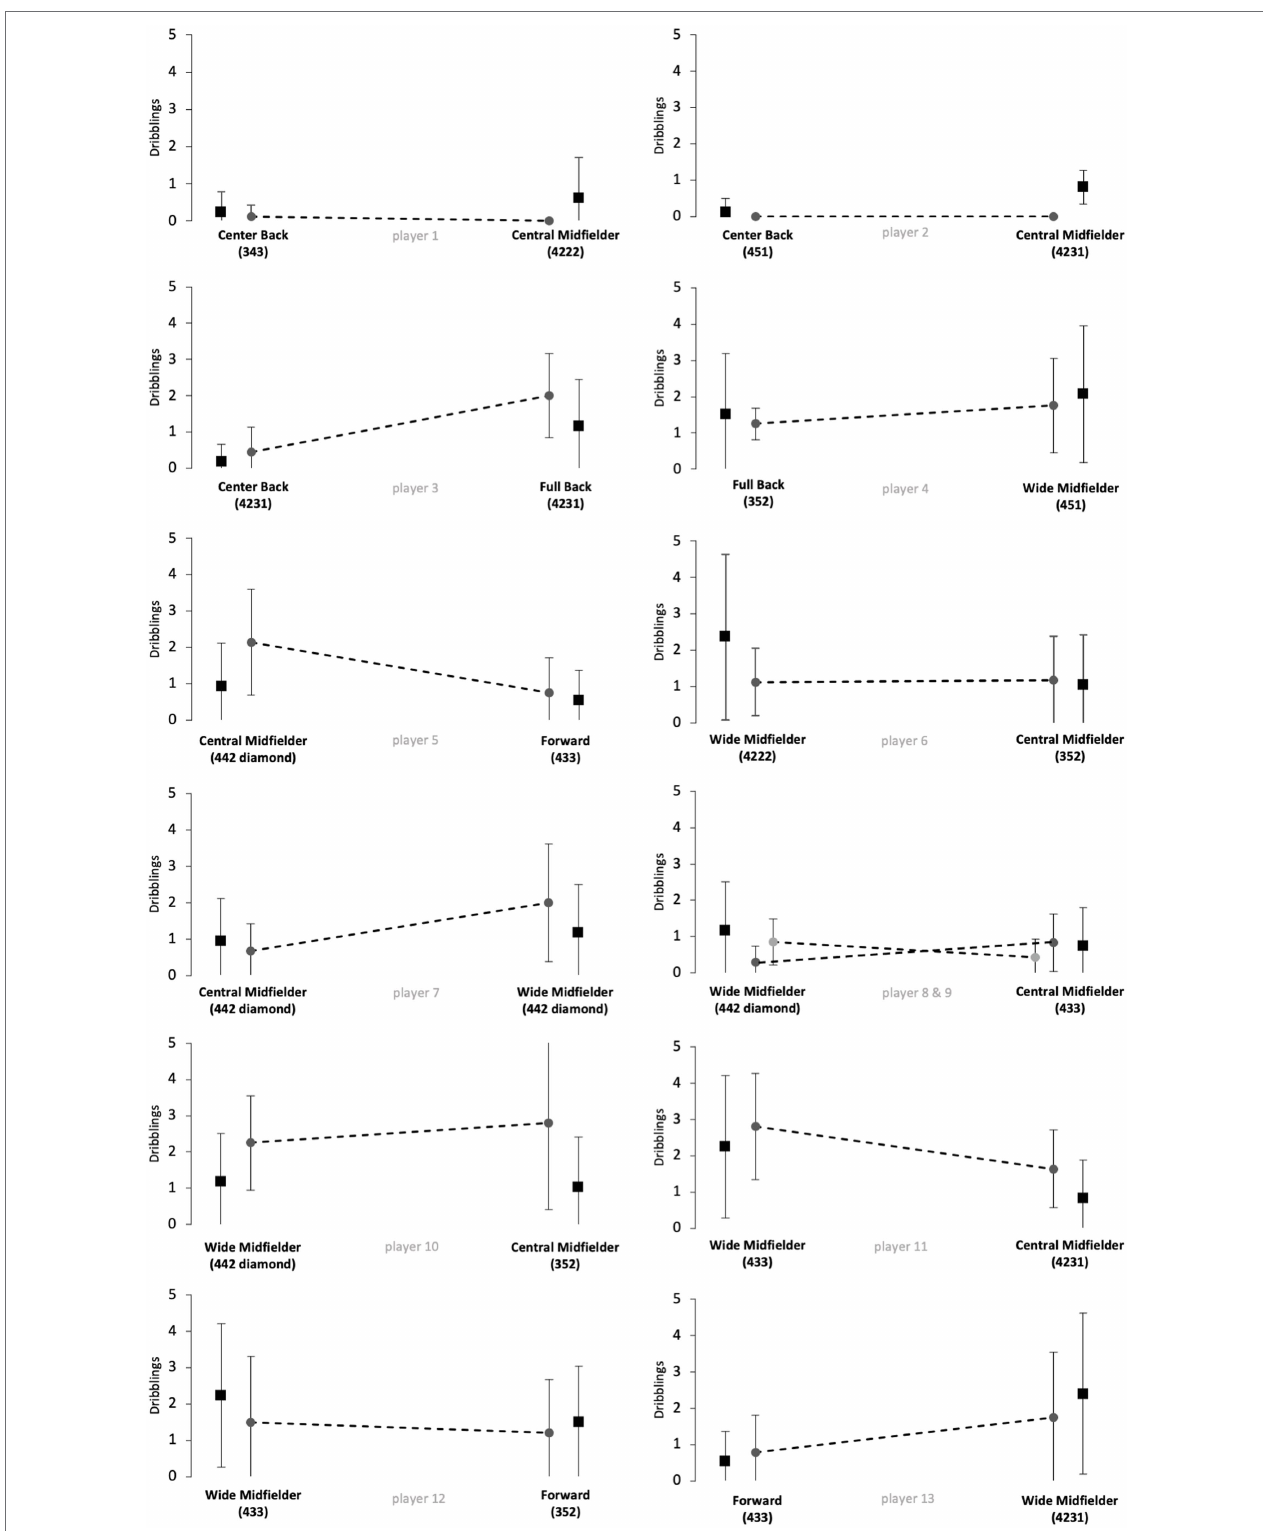
FIGURE 5 | Number of dribblings of players from the study sample (grey circles) in relation to normative positional data (black squares). Data are presented as means ± SD for the respective games played on the respective positional role. Solid lines indicate significant differences in performance between the two positions for the respective